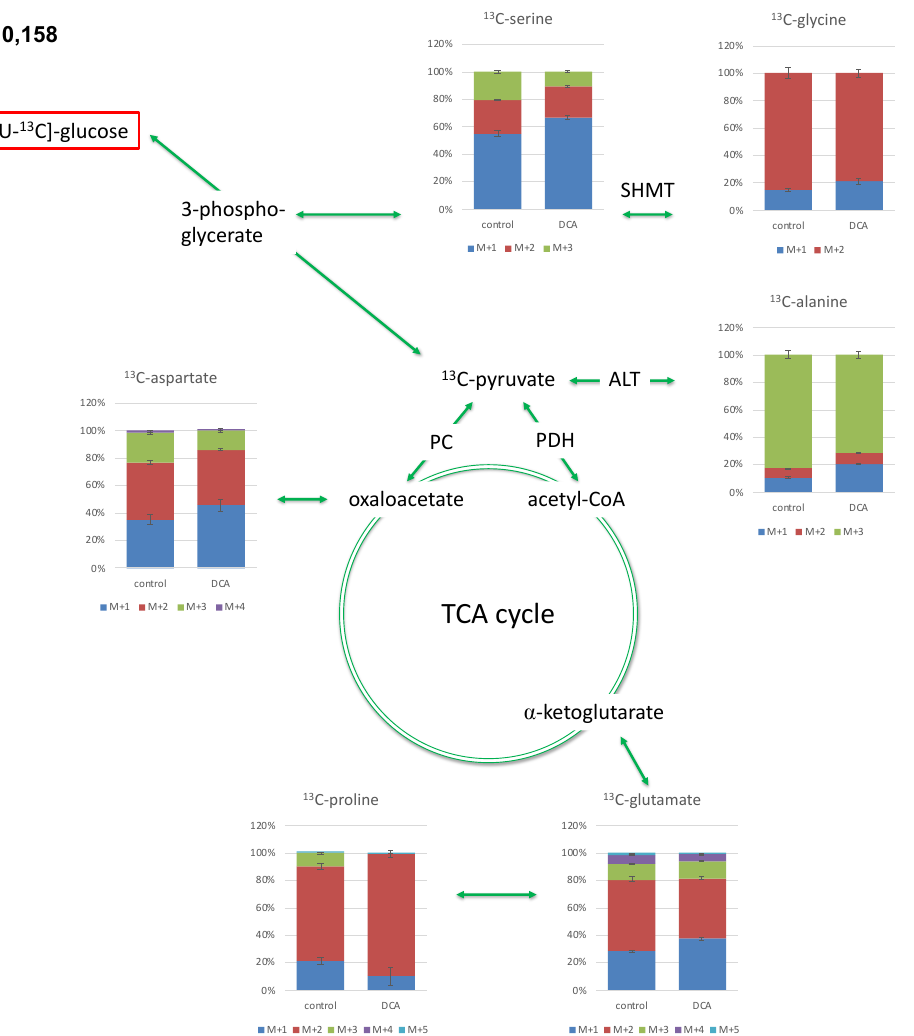
Figure 5. 13 C isotopologue profiles of serine, glycine, alanine, glutamate, proline and aspartate following incubation of 10,158 cells with DCA compared to untreated controls. Relative fractions of isotopologues (M + 1 – M + 5) in the overall 13 C-labelled amino acids are indicated by different colors. ALT: alanine aminotransferase; PC: pyruvate carboxylase; PDH: pyruvate dehydrogenase; SHMT: serine hydroxymethyltransferase; N = 3.